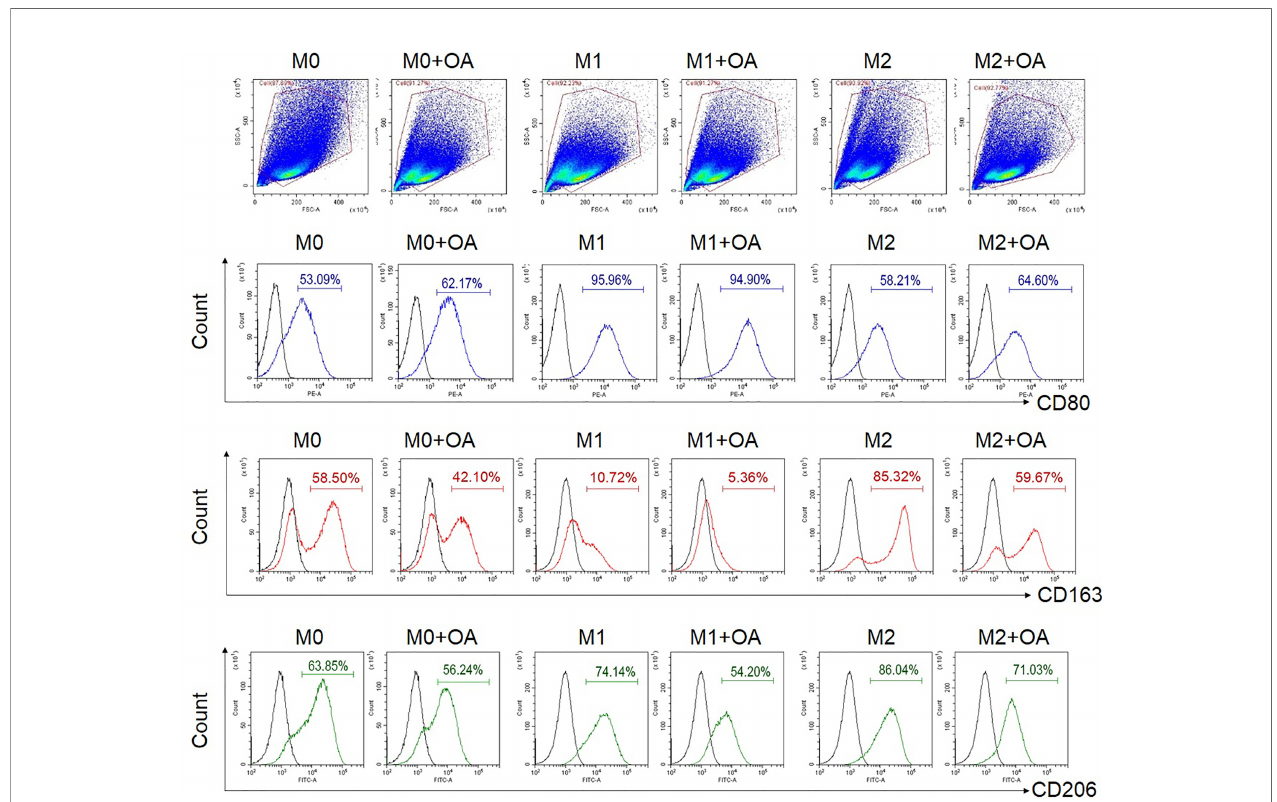
FIGURE 2 | Flow cytometry analysis of surface expressions. MDMs at day 6 were cultured in complete medium only (M0), LPS + INF- g (M1), or IL-4 (M2) in the presence or absence of oleamide (15 µg/ml) for 24h. LPS, lipopolysaccharides; OA,